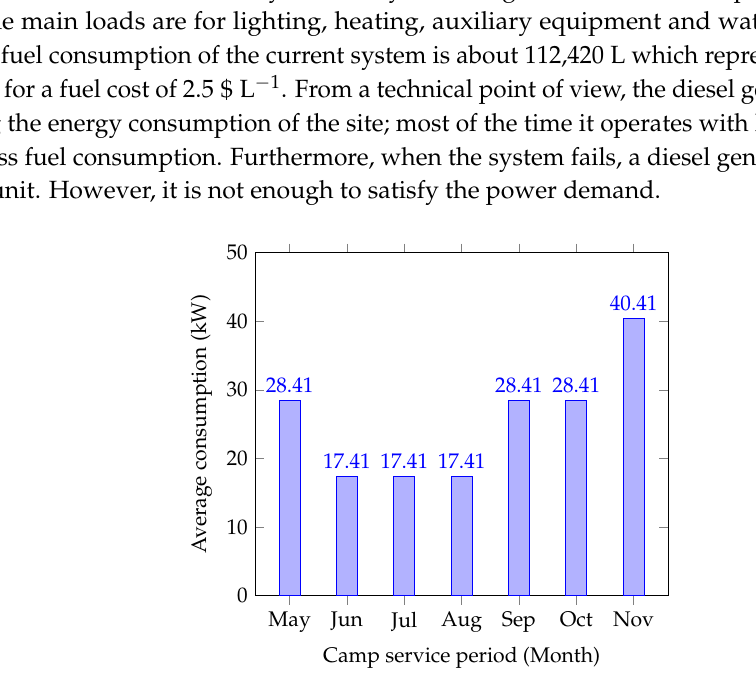
Figure 3. Average consumption profile of Esker Camp from May to November 2014.